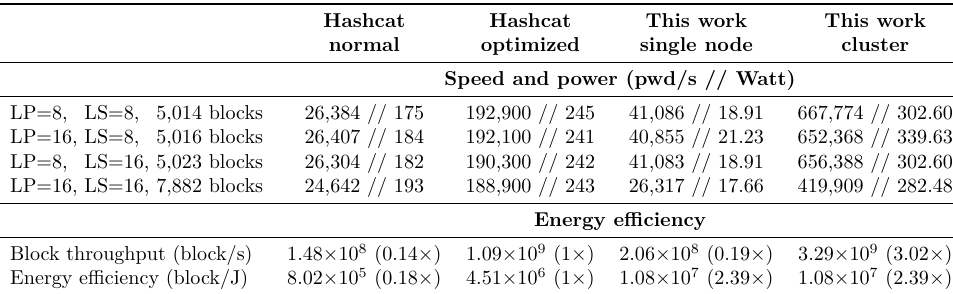
Table 9: Comparison with Hashcat running on a GTX1080Ti for sha512crypt.